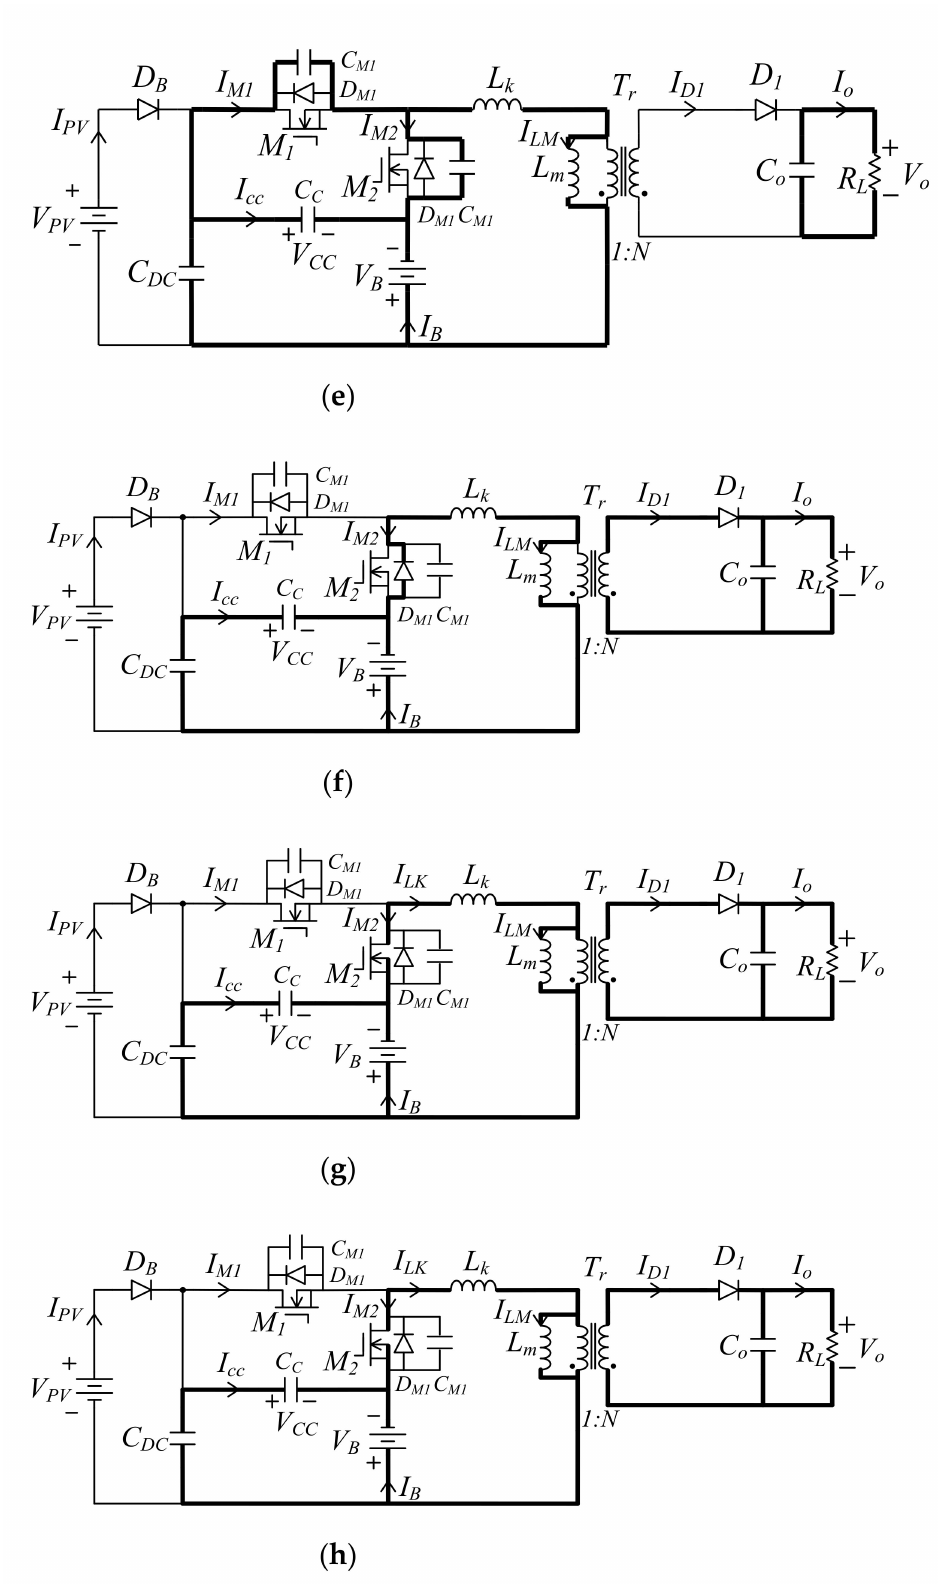
Figure 11. Equivalent circuit of the proposed hybrid converter operated in the discharging mode over one switching cycle. ( a ) Mode 1 ( t 0 ≤ t < t 1 ); ( b ) Mode 2 ( t 1 ≤ t < t 2 ); ( c ) Mode 3 ( t 2 ≤ t < t 3 ); ( d ) Mode 4 ( t 3 ≤ t < t 4 ); ( e ) Mode 5 ( t 4 ≤ t < t 5 ); ( f ) Mode 6 ( t 5 ≤ t < t 6 ); ( g ) Mode 7 ( t 6 ≤ t < t 7 ); ( h ) Mode 8 ( t 7 ≤ t < t 8